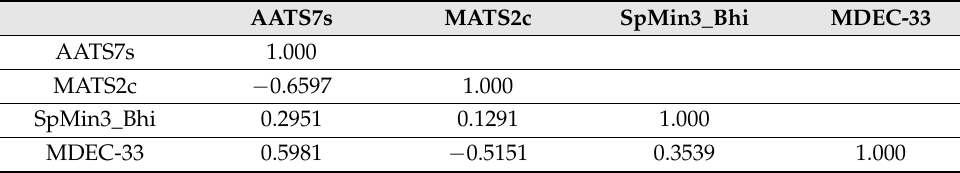
Table 2. Descriptor correlation matrix for the best